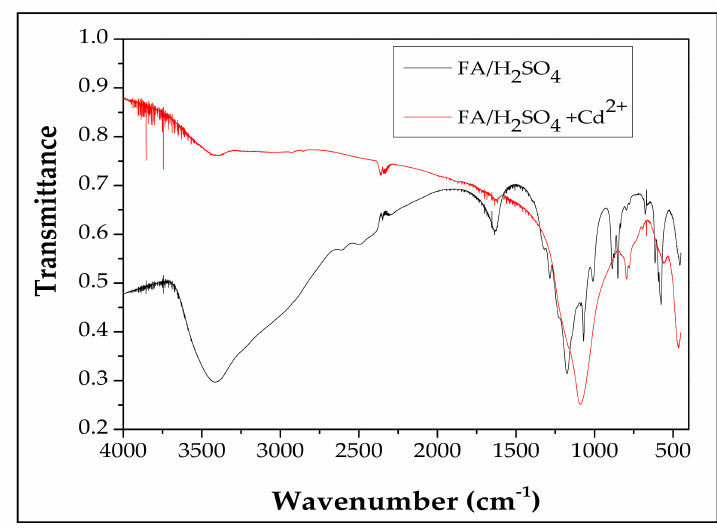
Figure 3. FTIR spectra of FA / H 2 SO 4 and FA / H 2 SO 4 + Cd 2 + .